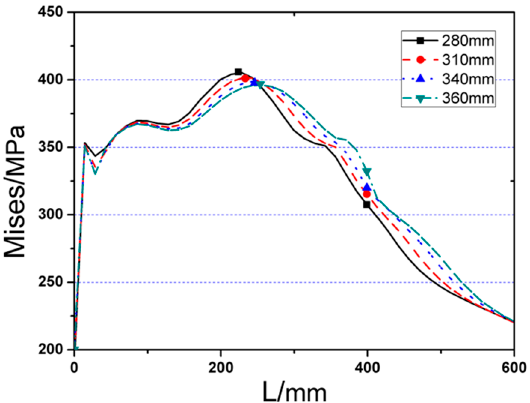
Figure 13. The Von Mises stress distribution along beam length (start from steel tube) of RB series FE joint models.